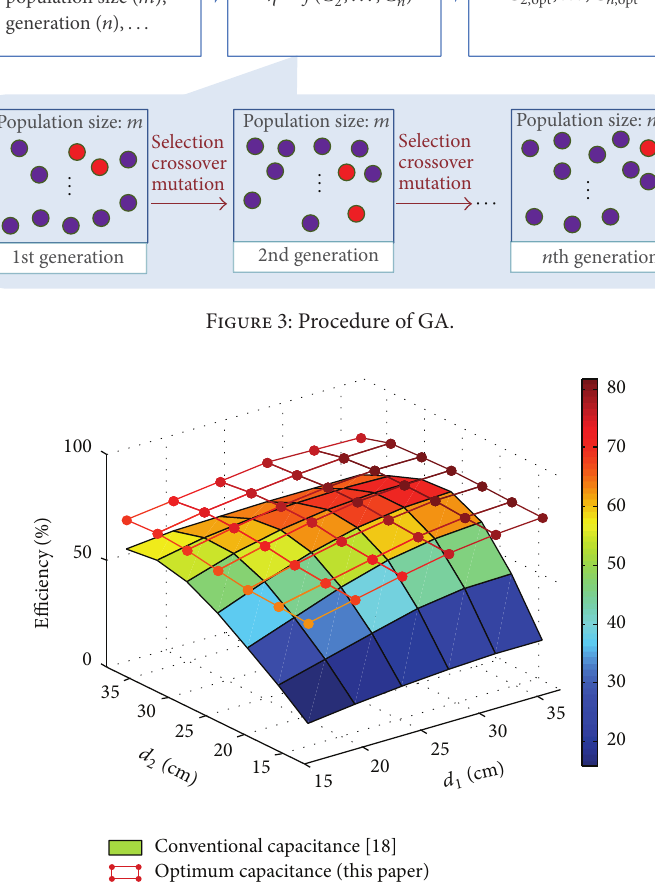
Figure 4: Optimum power transfer efficiency versus the various placement of two relay resonators ( 𝑓 = 6.78